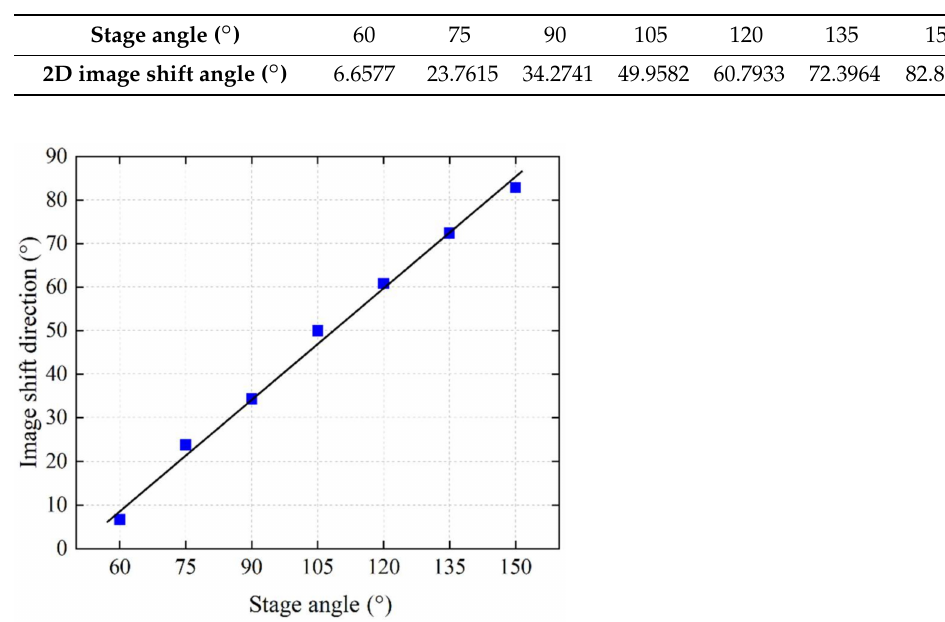
Figure 13. Trajectories of the 2D dynamic speckle patterns with different rotation stage angles. ( a ) Stage angle was 60 ◦ . ( b ) Stage angle was 75 ◦ . ( c ) Stage angle was 90 ◦ . ( d ) Stage angle was 105 ◦ . ( e ) Stage angle was 120 ◦ . ( f ) Stage angle was 135 ◦ . ( g ) Stage angle was 150 ◦ . Table 1. Relationship between rotation stage angle and the 2D image shift angle.